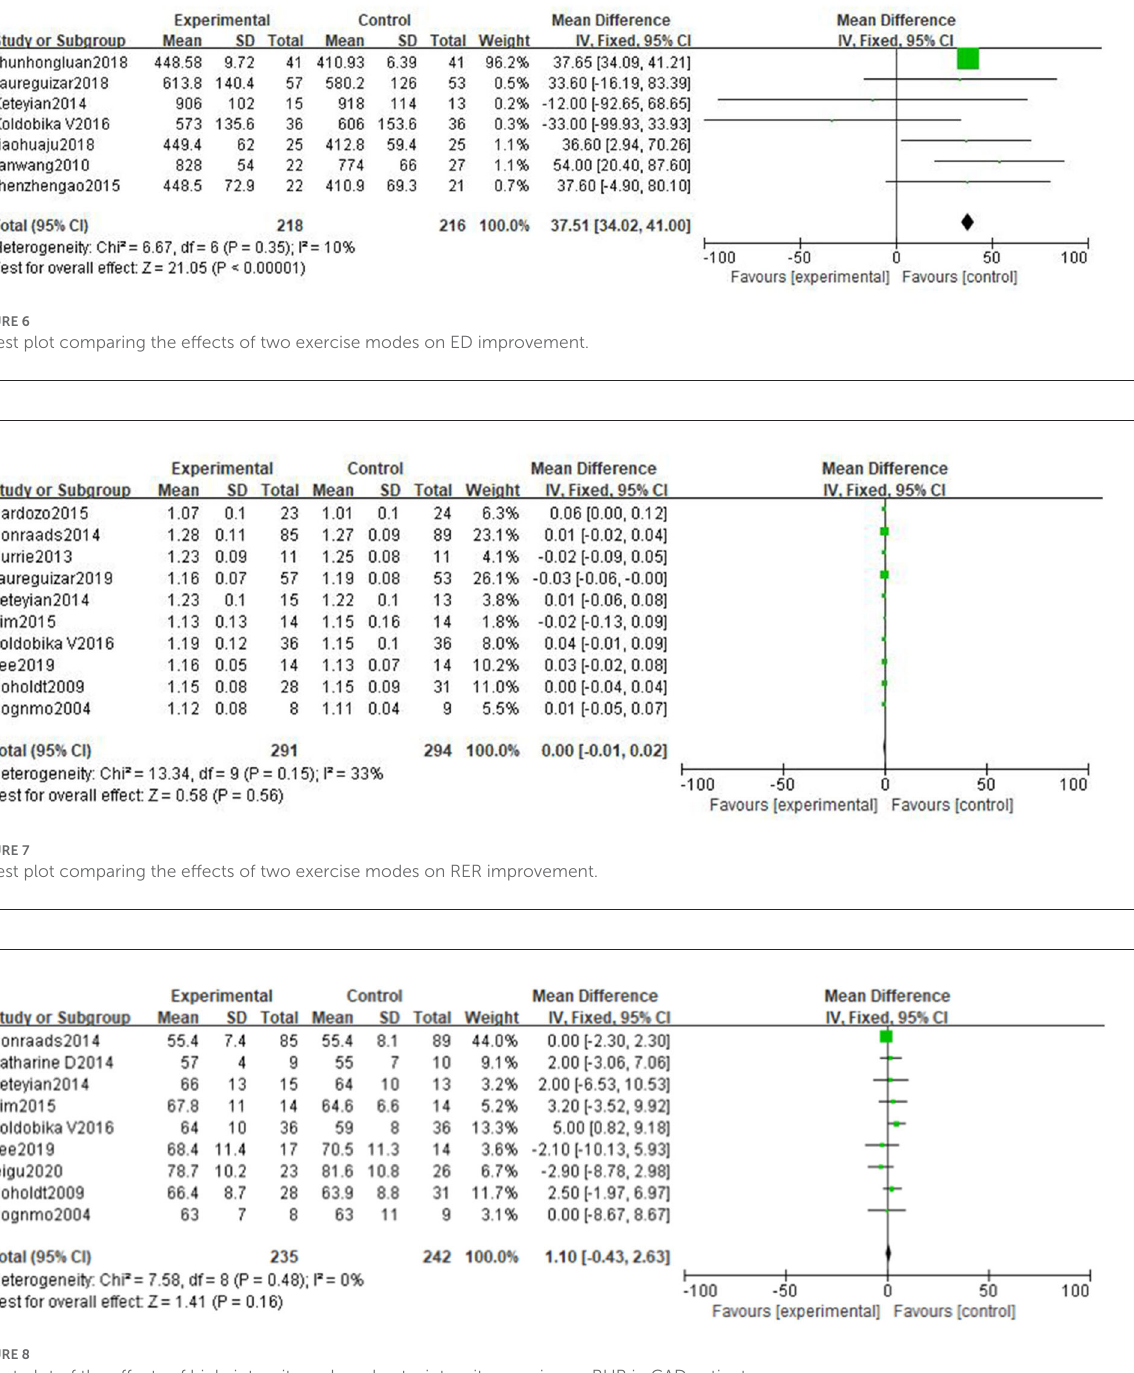
I 2 = 0%]. However, there is no significant difference in the improvement effect of the two exercise intensities on O 2 pulse when Wang et al. (28) was removed [MD =